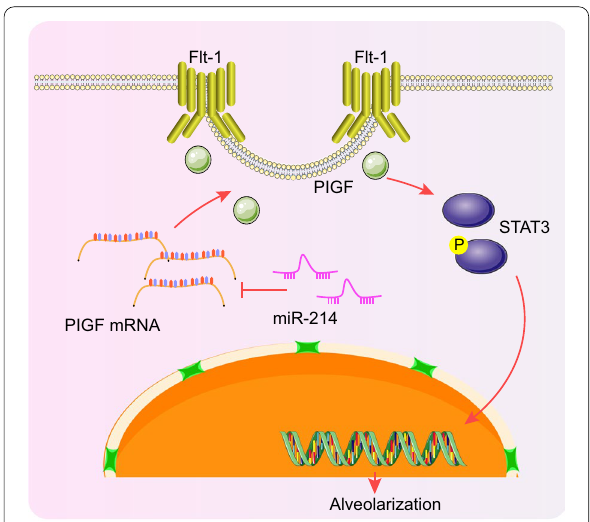
Fig. 8 A schematic diagram illustrating the roles of the miR‑214‑PlGF‑STAT3 regulatory network in preterm infants with BPD. miR‑214 can inhibit the activation of the STAT3 pathway by inhibiting the transcription of its downstream target gene PlGF, ultimately enhancing alveolarization in preterm infants with